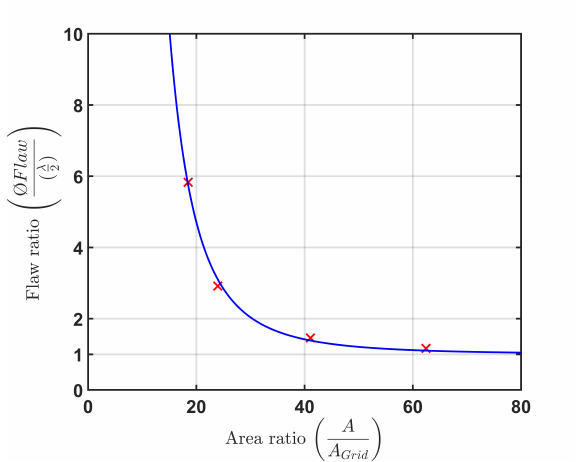
Figure 17. Determinable flaw ratio in relation to the area ratio.